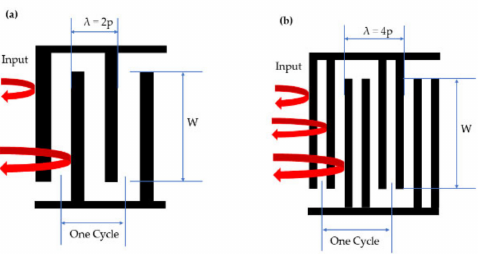
Figure 7. Schematic diagram of internal inflection of surface acoustic wave. ( a ) Single electrode transducers, ( b ) double electrode transducers. Table 3. The parameters of the SAW temperature sensors with double electrode transducers.